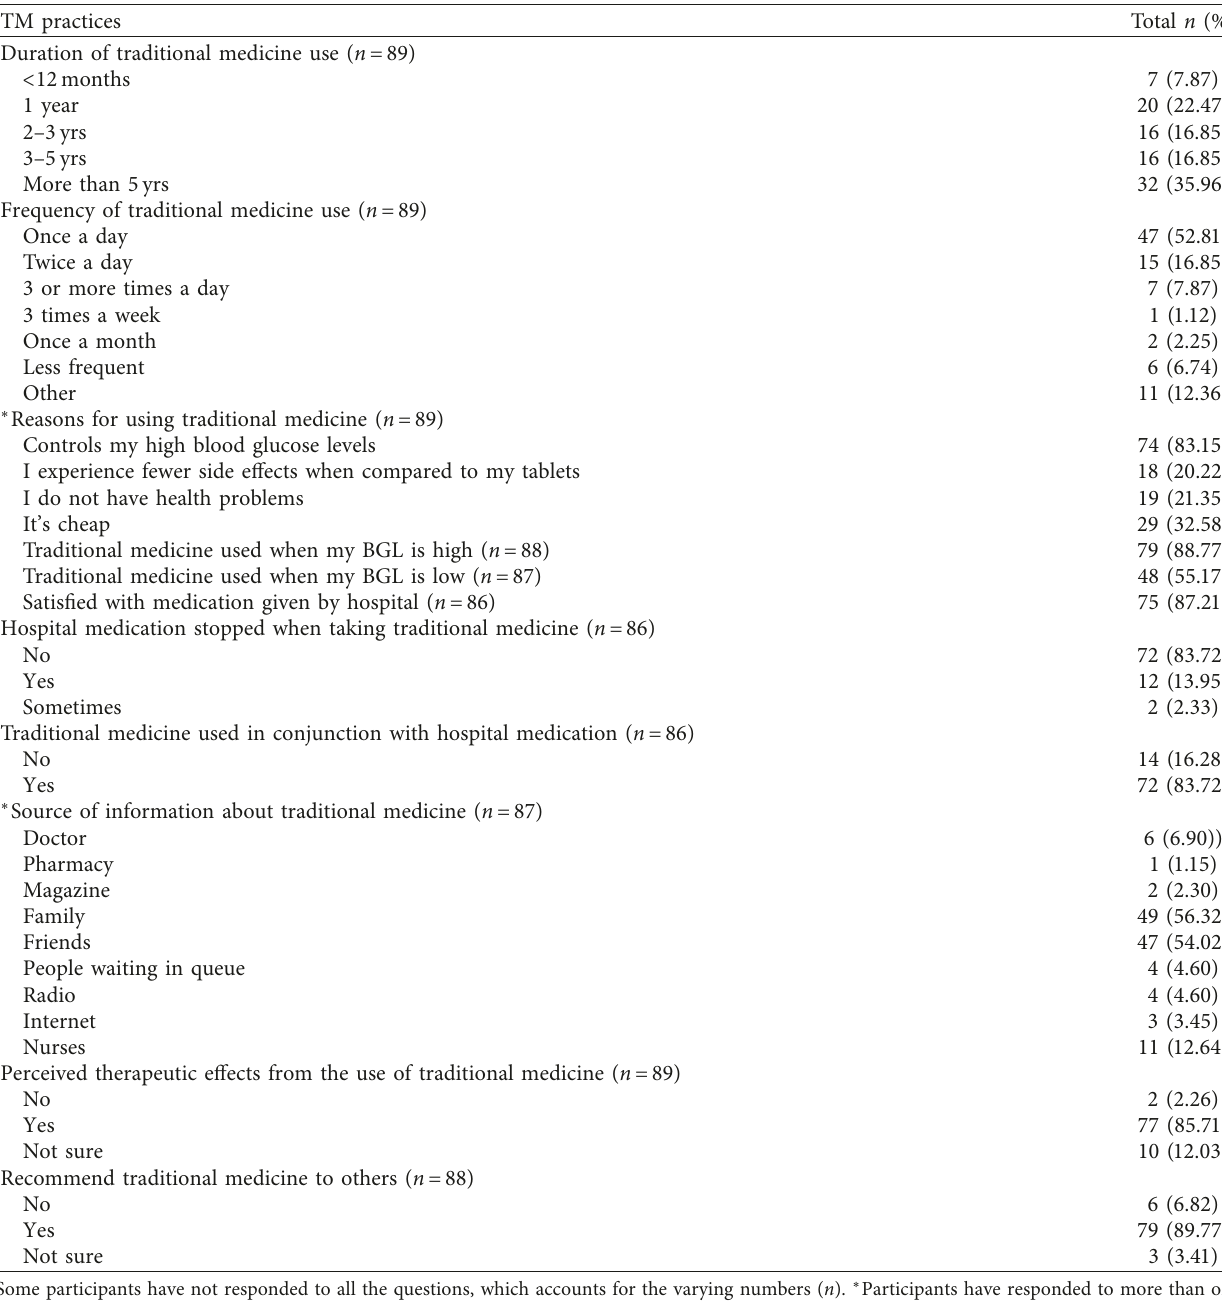
Table 3: Traditional medicine use among type 2 diabetes patients ( N �